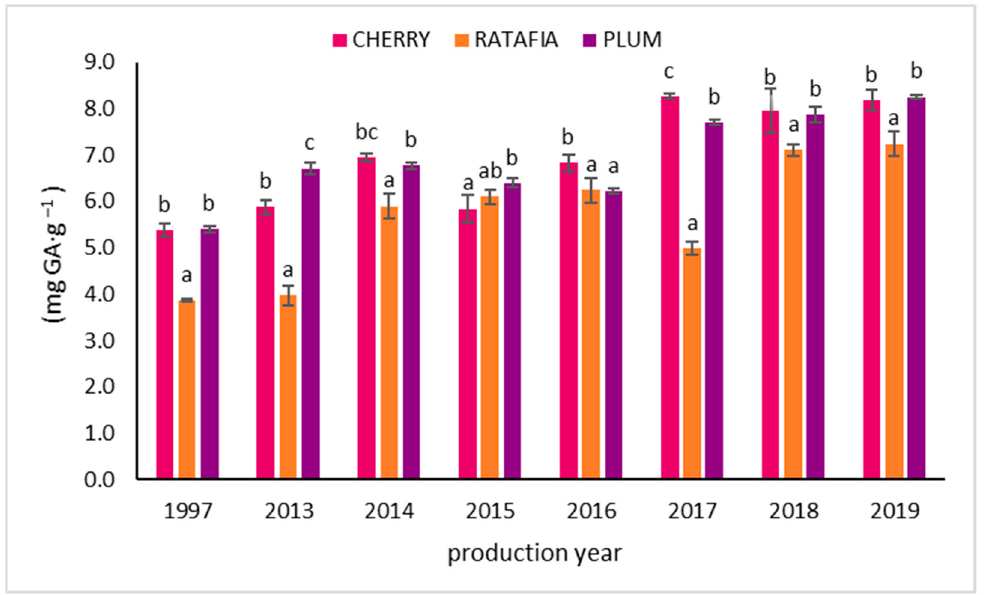
Figure 4. The total polyphenol content of nalewkas (mean ± SD, n = 3). Different letters indicate significant differences between the nalewkas in individual years of production ( α = 0.05). The result was expressed in mg GA·g − 1 of nalewka; GA—gallic acid.